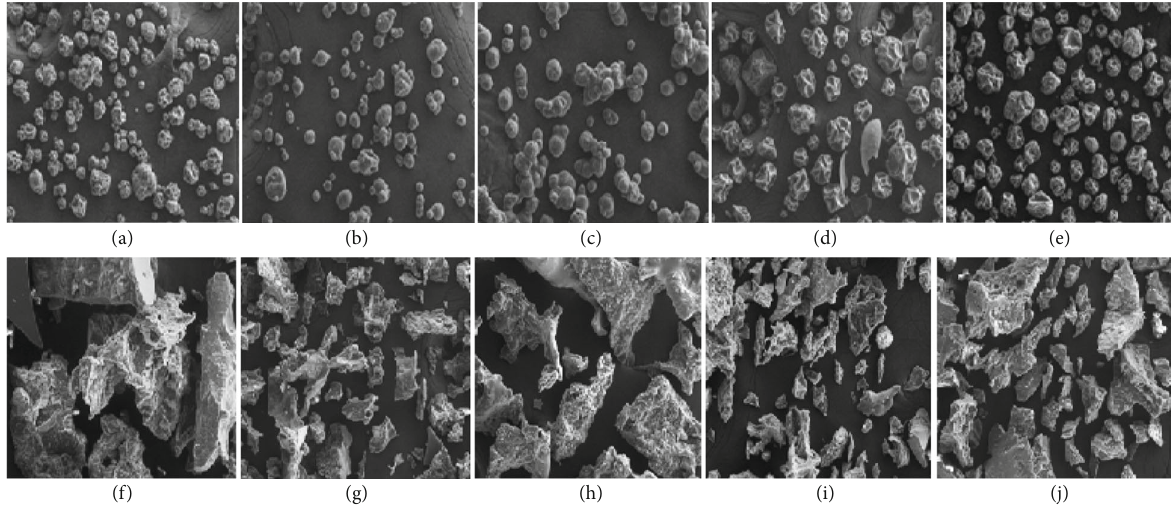
Figure 5: Surface morphology ( × 200 magni fi cation) of (a – e) spray- and (f – j) freeze-dried Zn-amaranth powders encapsulated with (a, f) MD, (b, g) RMD, (c, h) HICAP, (d, i) CAP, and (e, j) GA (MD: maltodextrin; RMD: resistant maltodextrin; HICAP: HI CAP 100; CAP: Capsul; GA: gum